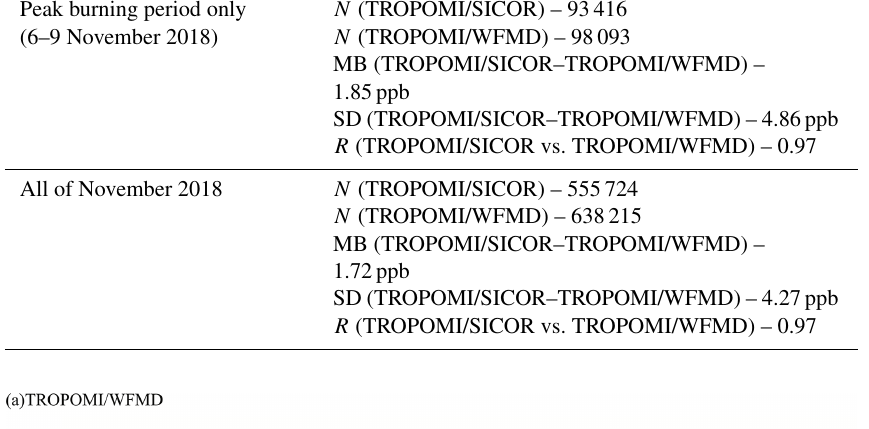
Table 4. Comparison between TROPOMI/WFMD and TROPOMI/SICOR products over India during the burning period and the full month of November 2018. Abbreviations N , MB, SD, and R correspond to the number of observations, mean bias, standard deviation of differences, and correlation coefficient, respectively.